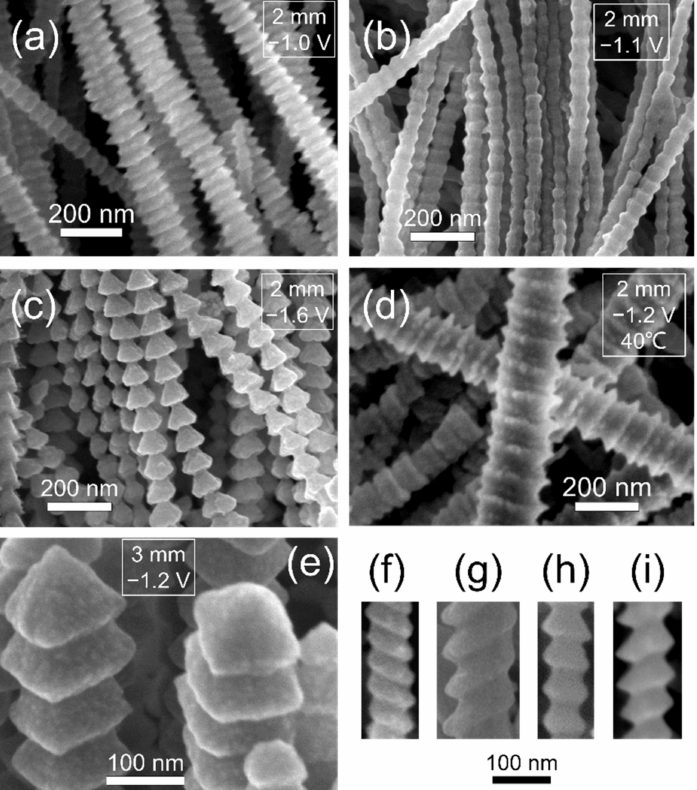
Figure 8. SEM images of Al nanowires electrodeposited at ( a ) − 1.0 V/25 ◦ C, ( b ) − 1.1 V/25 ◦ C, ( c ) − 1.6 V/25 ◦ C and ( d ) − 1.2 V/40 ◦ C under the restricted diffusion condition with a 2